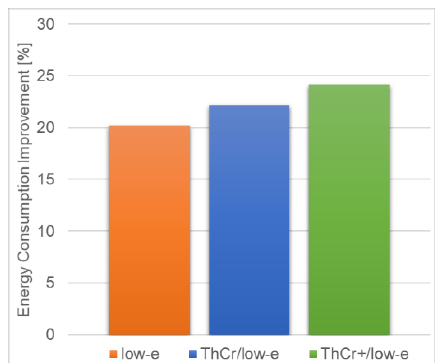
Figure 12. Comparison of annual energy consumption improvement (heating + cooling + lighting) of low-e glazing, thermochromic / low-e glazing (ThCr / low-e) and a theoretical optimized thermochromic / low-e glazing (ThCr +/ low-e) over clear glass for a residential building in the Netherlands.